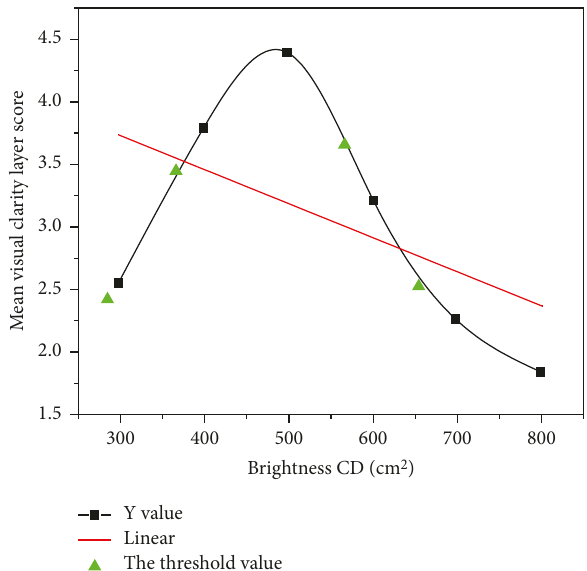
Figure 7: Variation trend of visual clarity and